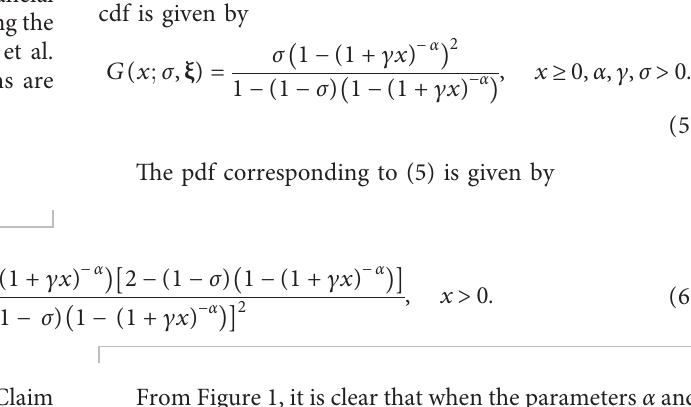
Figure 1 are presented for α � 1 . 8 , c � 1 , and σ � 1 . 6 (red-line), α � 1 . 4 , c � 1 , and σ � 1 . 8 (green-line), and α � 3 . 5 , c � 1 , and σ � 2 . 5